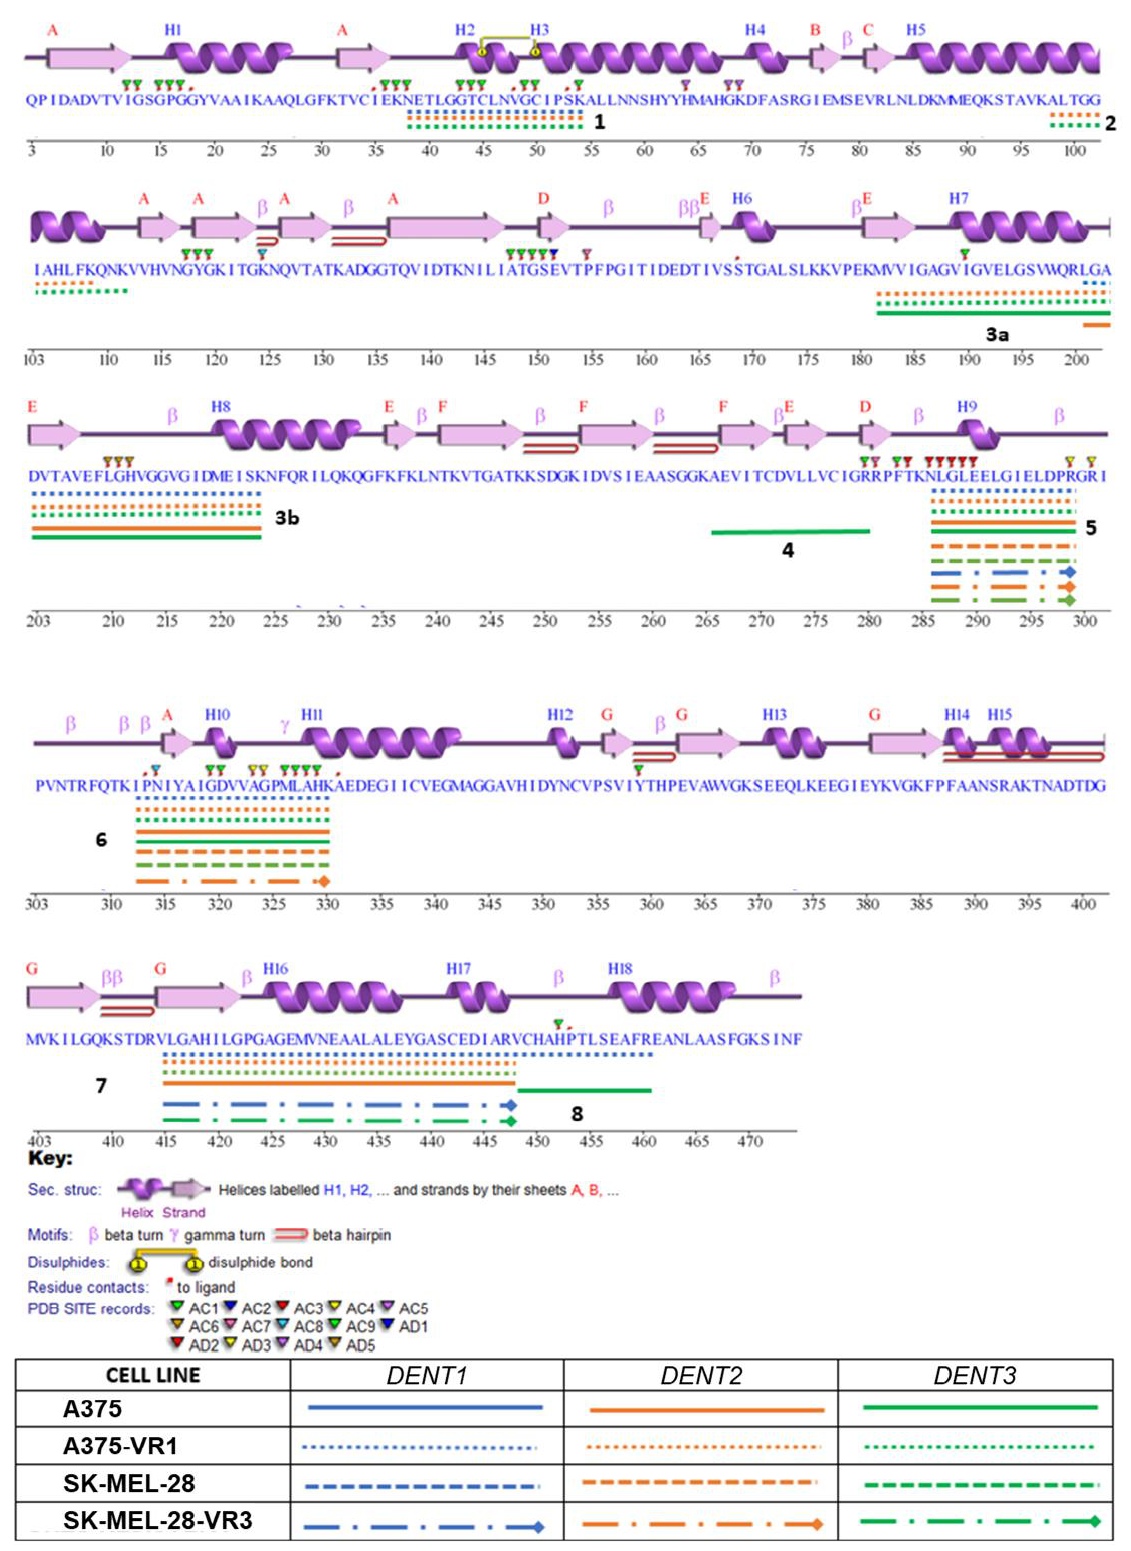
Figure 5. Protein sequence coverage by mass spectrometry of DLD. A visualization of the sequence chain of DLD is presented. Lines correspond to the digested peptides identified (using Proteome Discoverer™ software version 1.4 (Thermo Fisher Scientific, Waltham, MA, USA)) by each of the denaturation treatments of the TRIDENT protocol followed by LC-MS/MS analysis, as previously described [34].